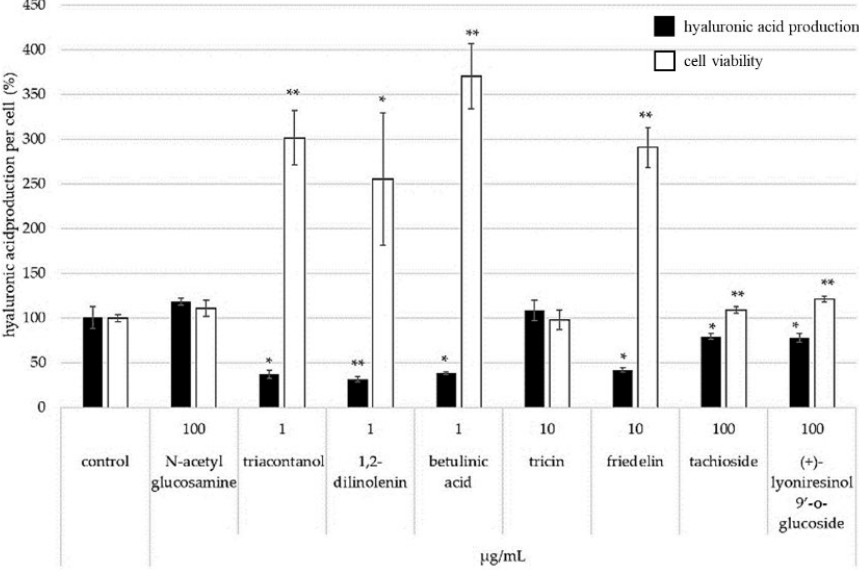
Figure 7. Effect of isolated compounds on the production of hyaluronic acid (* p < 0.05 and ** p < 0.01). Figure 8 shows collagen production per cell after treatment of each isolated compound. Tricin and (+)-lyoniresinol 9 (cid:48) - O -glucoside have an effect to increase collagen production. These results indicated that isolated compounds of bamboo affect skin whitening, retain moisture, and protect wrinkles.